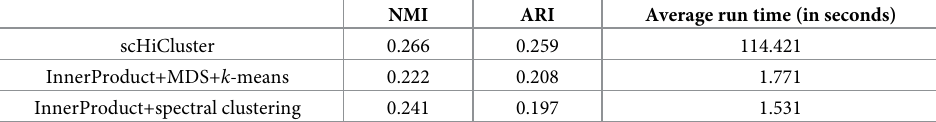
Table 2. The normalized mutual information (NMI), adjusted rand index (ARI), and run time of three clustering approaches. (Data: 750 embryo cells at five differentiation stages, including 1-cell, 2-cell, 4-cell, 8-cell and 64-cell stages, Collombet et al.,